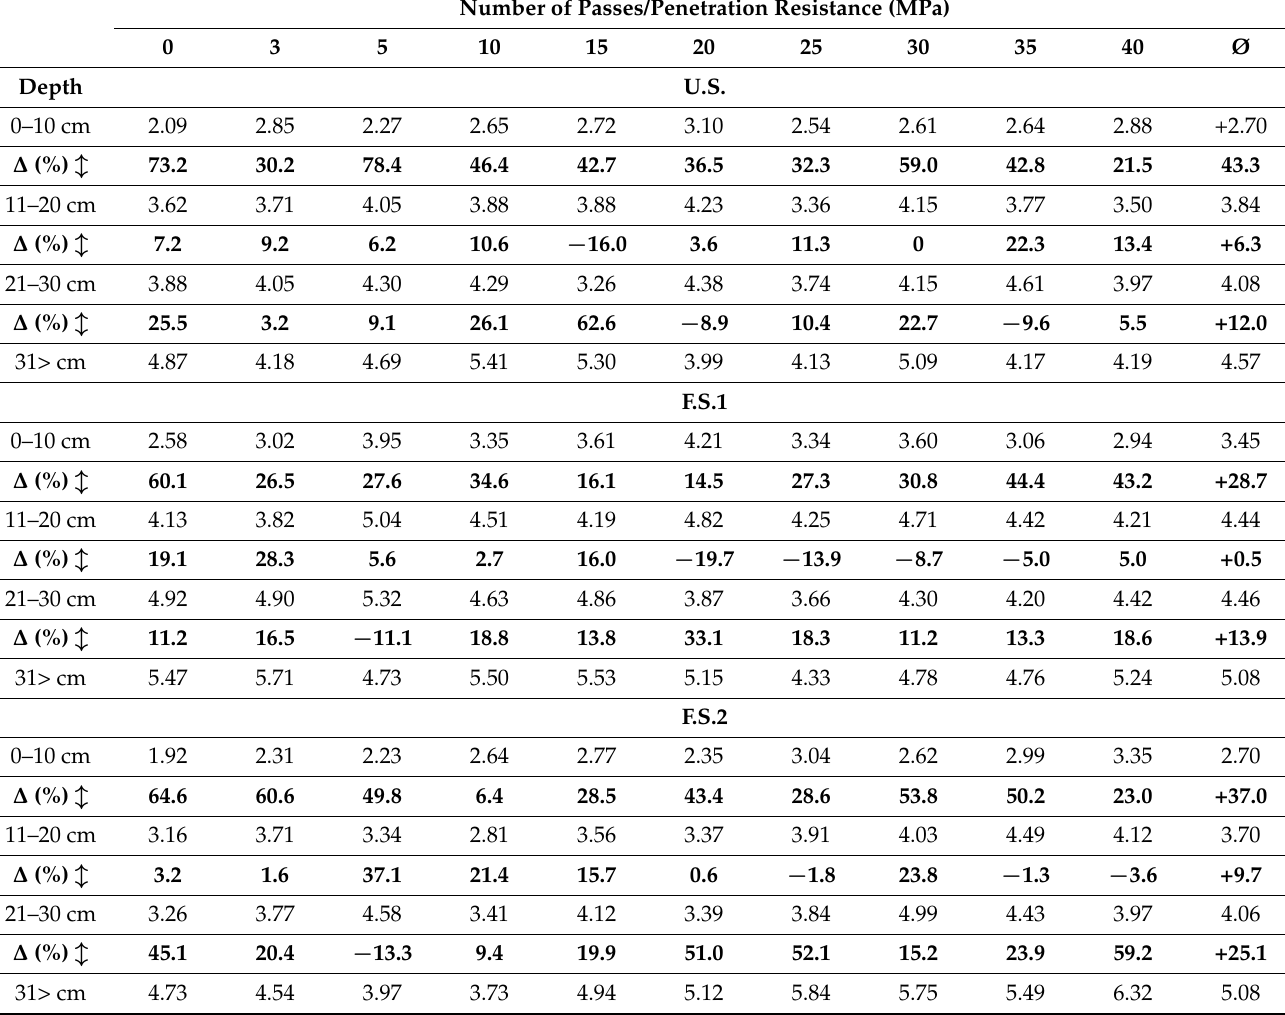
Table 8. Outcomes of the percentage differences in penetration resistance in various depth intervals for the individual machine